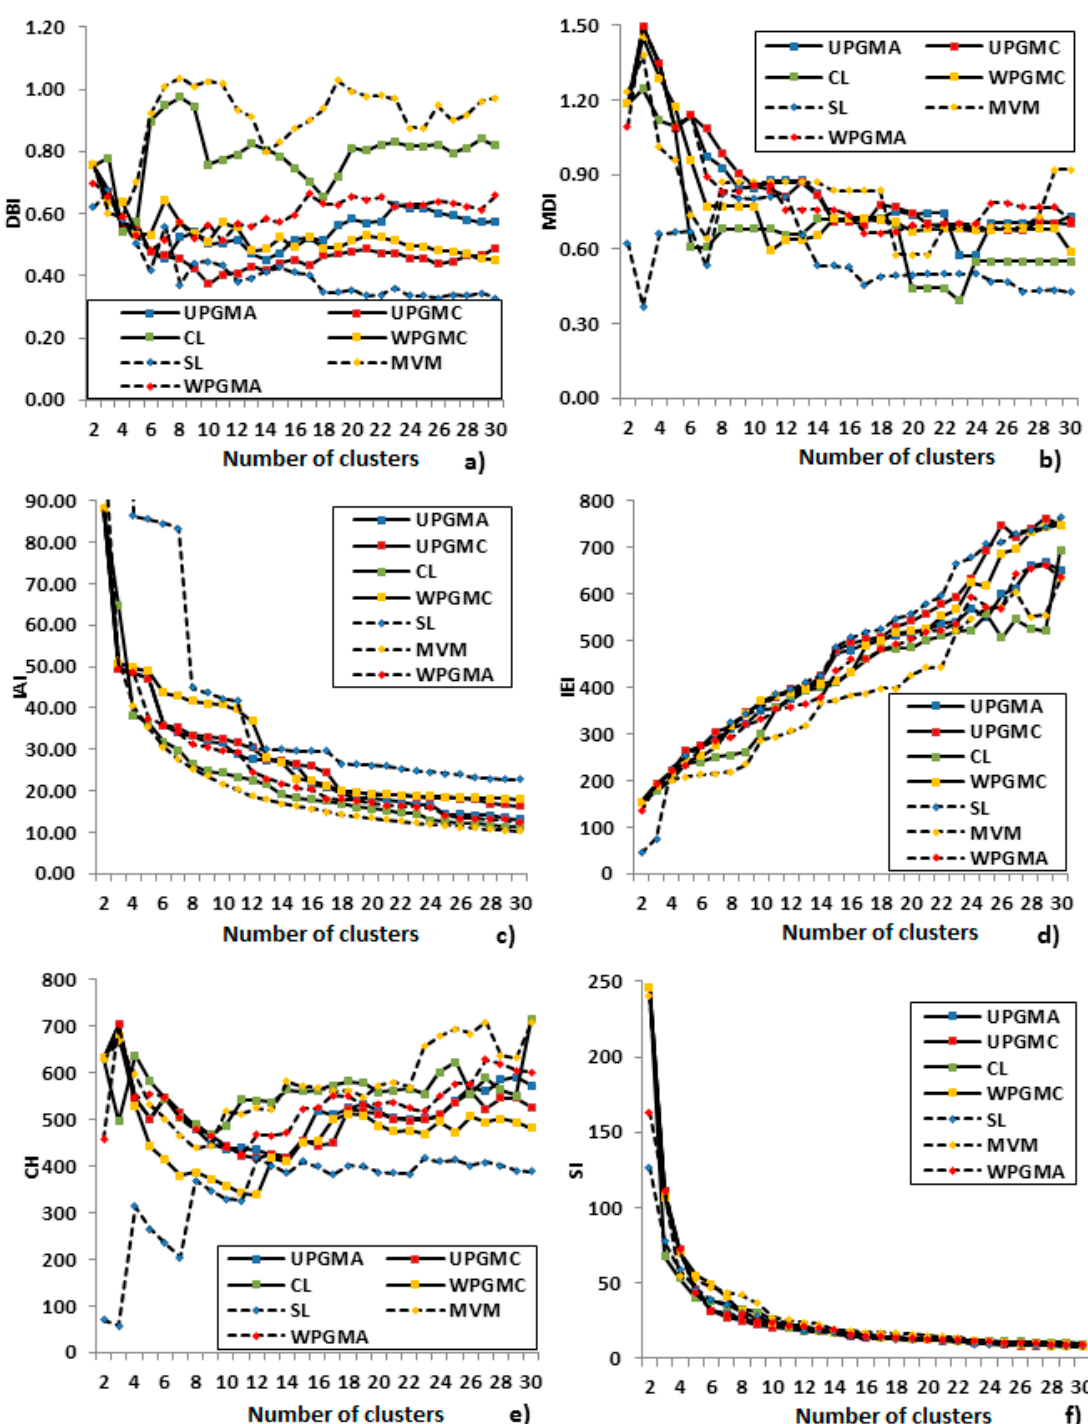
Figure 4. Comparison of the hierarchical algorithms using: ( a ) DBI, ( b ) MDI, ( c ) IAI, ( d ) IEI, ( e ) CH, ( f ) SI. Hierarchical agglomerative algorithms are characterized by the simplicity of their